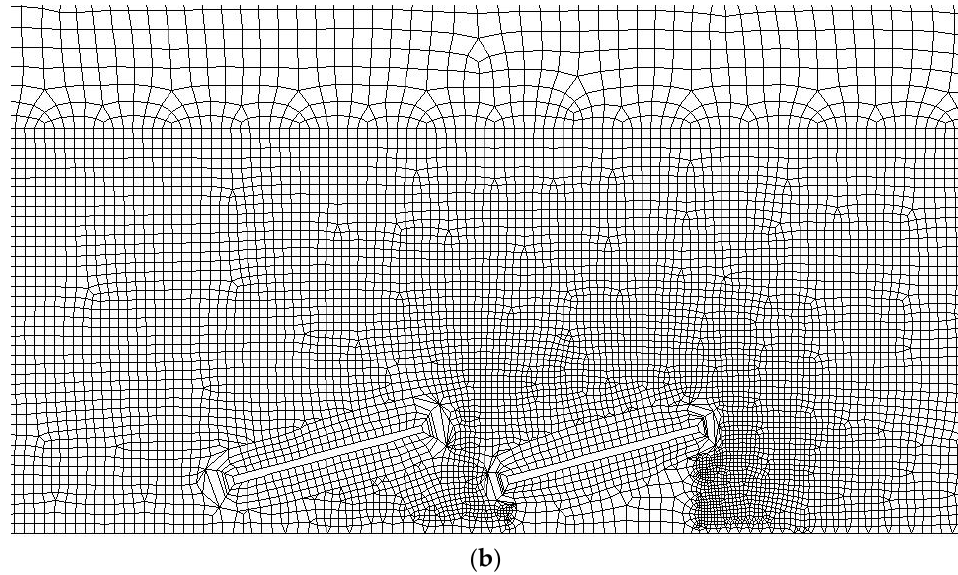
Figure 3. ( a , b ) Computational Domainand Mesh. Table 2. Grid Independence